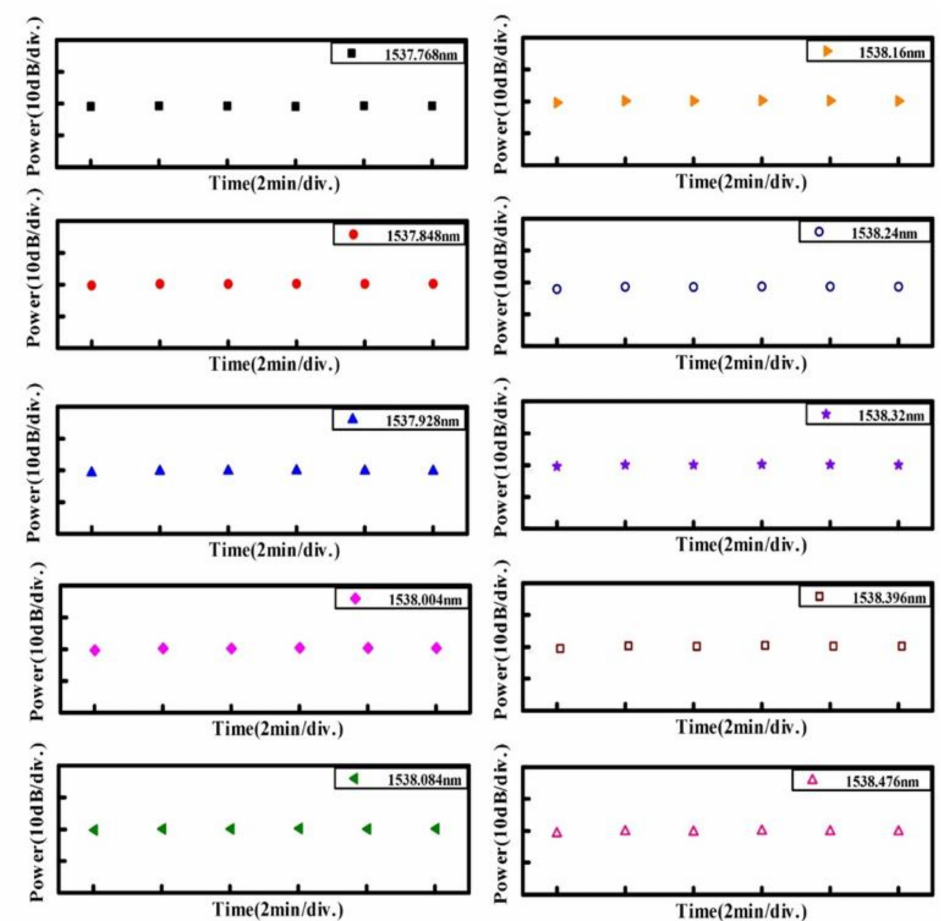
Figure 6. Output power stability for the selected wavelengths.